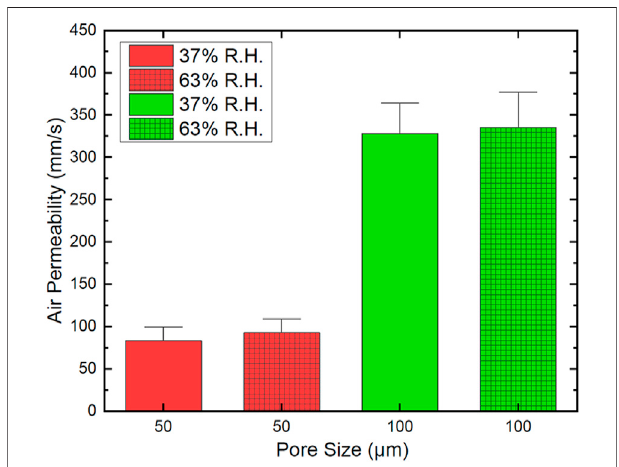
FIGURE5| Frequencydependencyoftheskin-electrodecontactimpedancemeasuredonthesamesubject(andonthesamespotintheforearm)ontwodifferent days (A,B) ,using20electrodeseachsession. (C,D) :positioningoftheelectrodesfortheimpedancecharacterizationandelectricalscheme,respectively.TheZ tattoo has been evaluated against the parallel of fi ve commercial electrodes (Z comm ) in order to make the latter negligible and thus having a more accurate measurement.